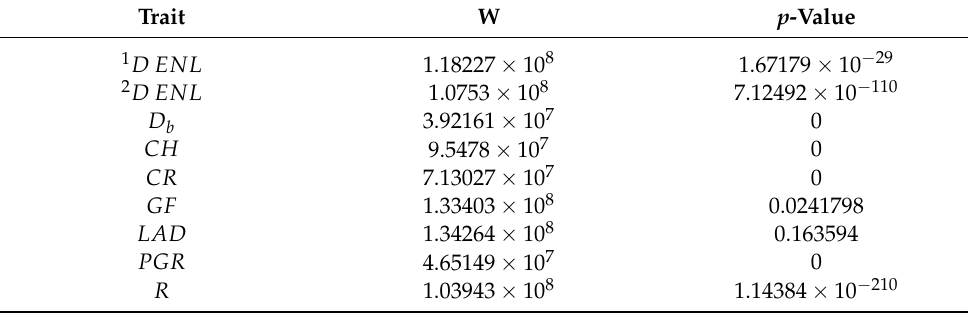
Table A2. Overview of Wilcoxon test results at 0.5 m grid